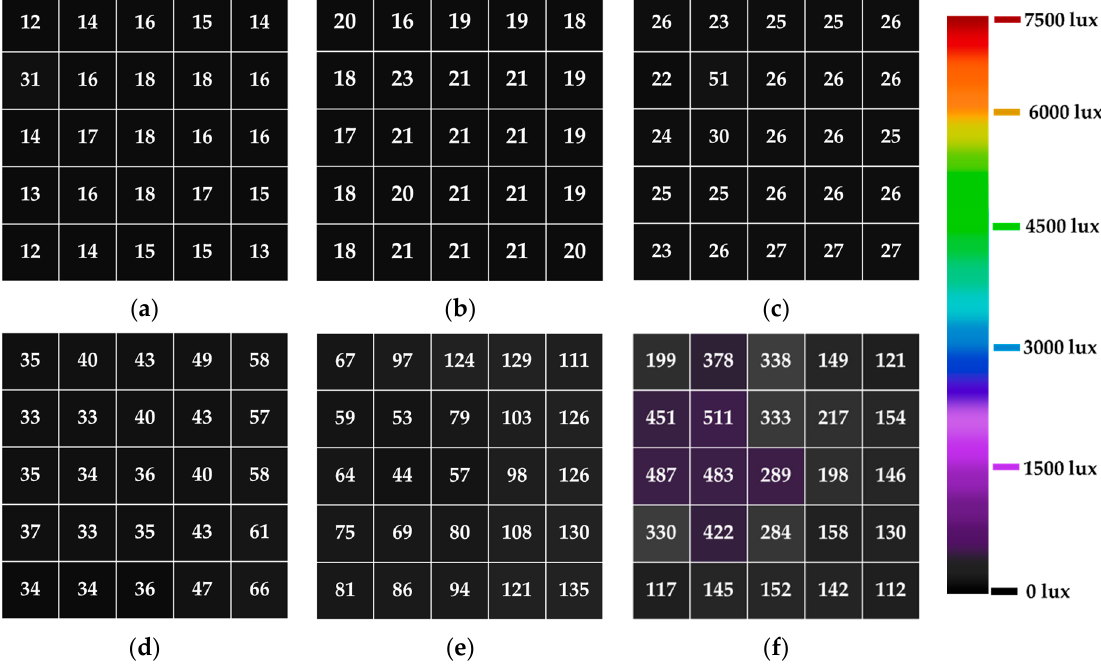
Figure 12. Illuminance distribution on the floor from the aluminum alloy light tube at the incident angles of ( a ) 0°, ( b ) 15°, ( c ) 30°, ( d ) 45°, ( e ) 60°, and ( f ) 75°.